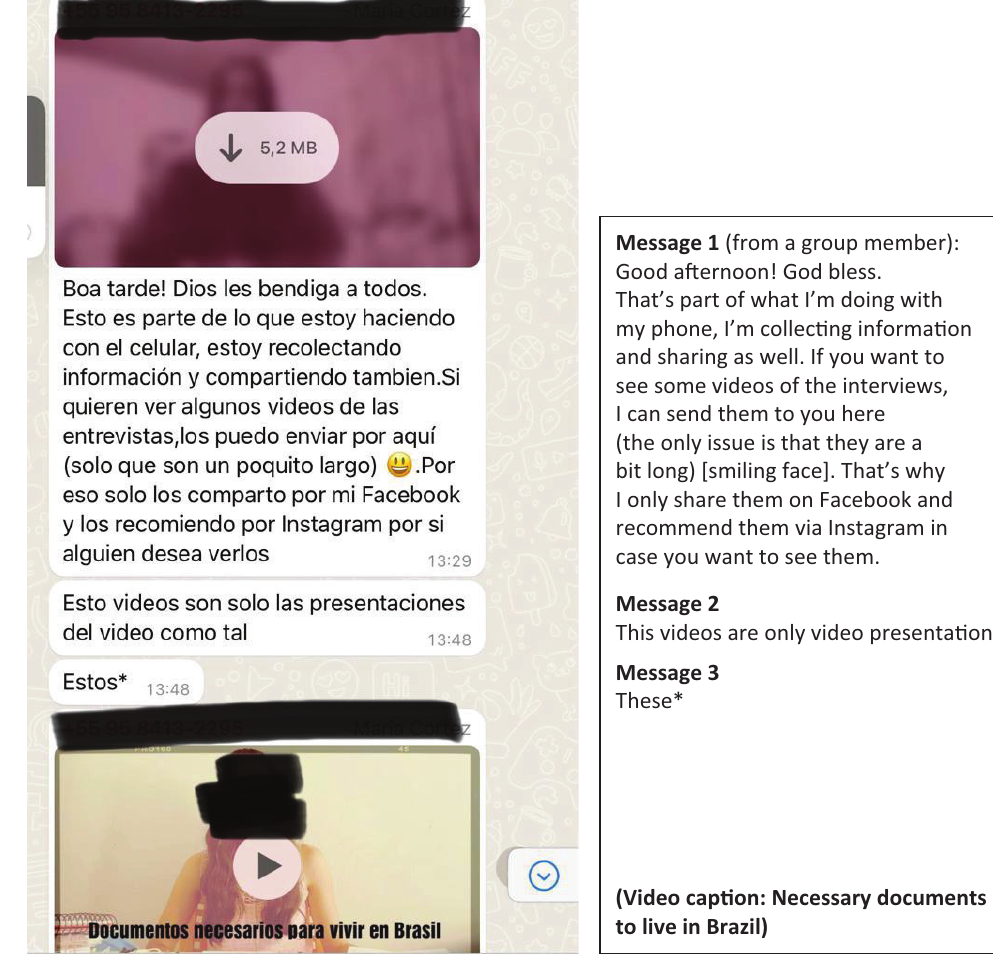
Figure 4. WhatsApp snapshot of posts by